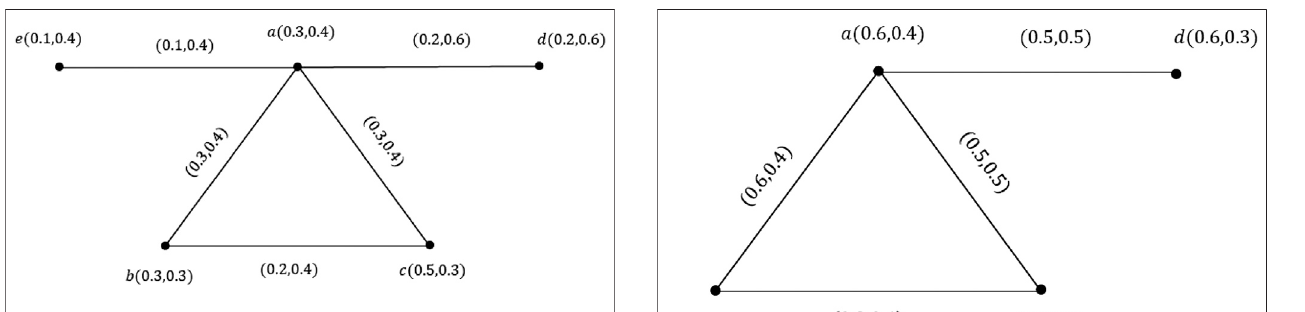
FIGURE 3 | Equitable dominating set of ζ .